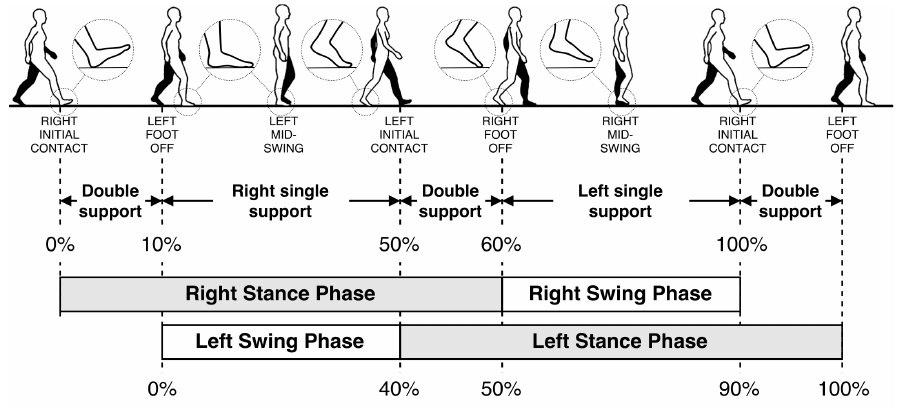
Figure 1. Human gait